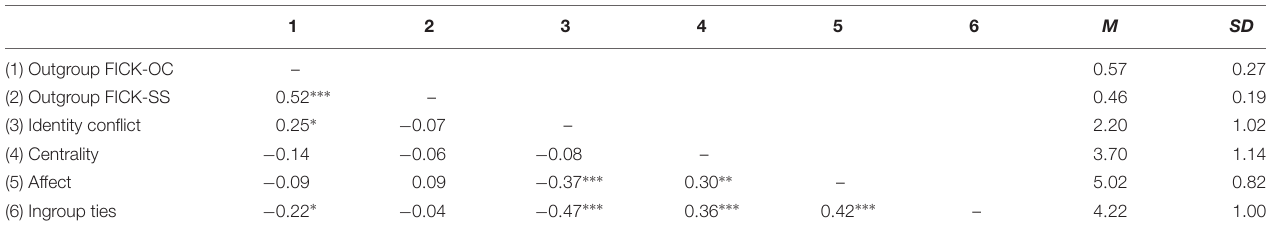
TABLE 1 | Descriptive statistics and intercorrelations of Study